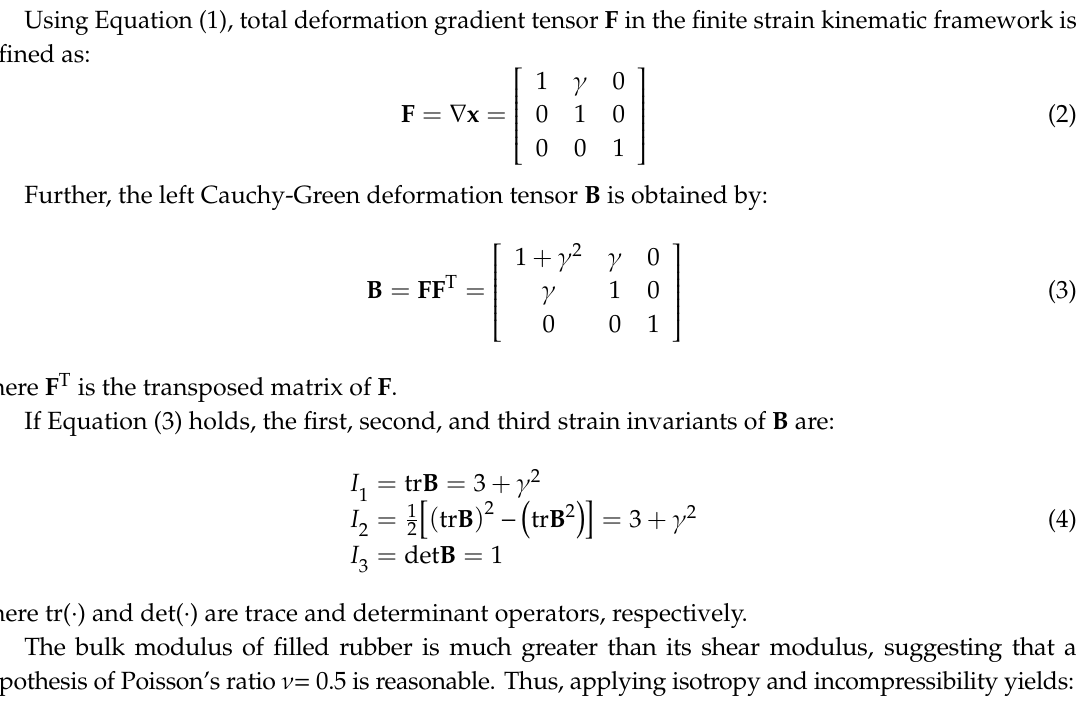
Figure 3. Reference and deformed configurations of simple shear deformation.